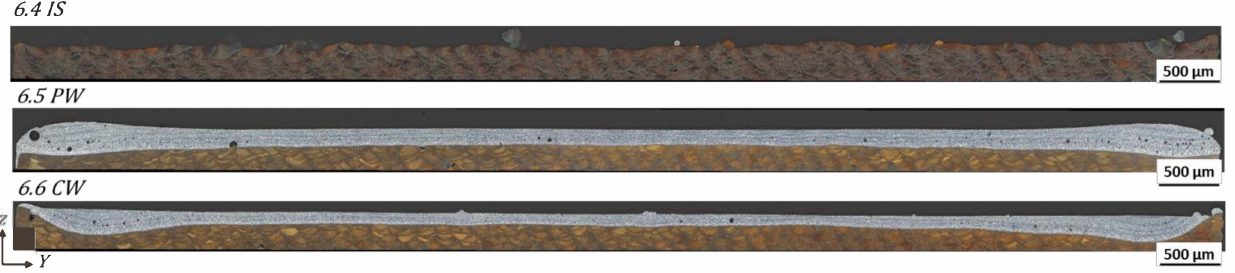
Figure 9. Etched cross sections of the cantilevers in y-direction.